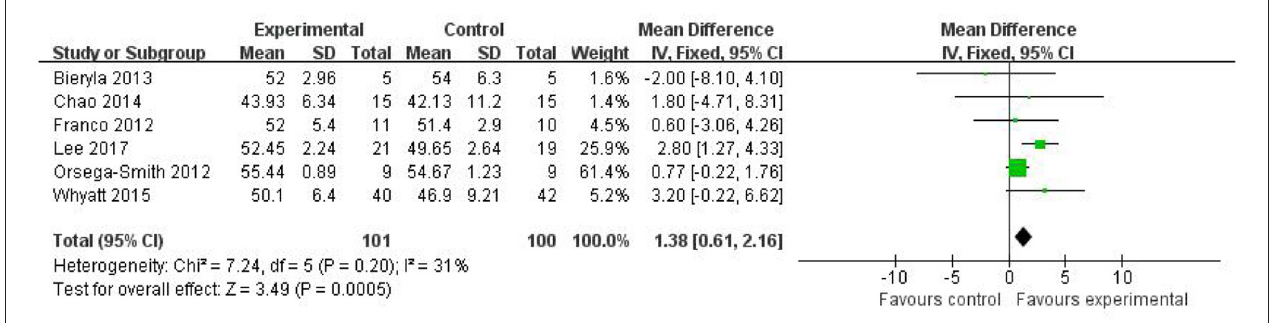
FIGURE 2 | Effect of Wii Fit with berg balance scale.